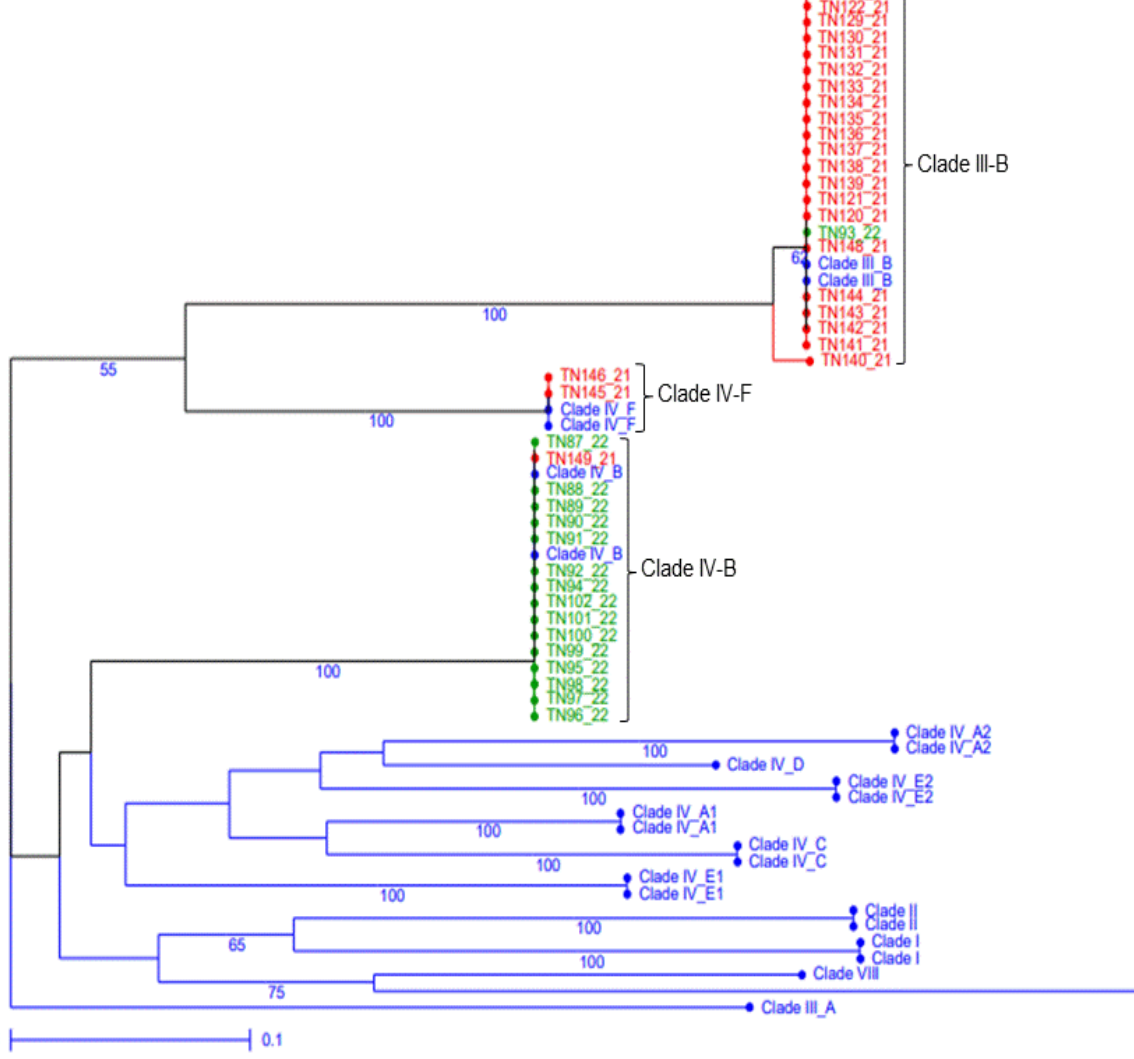
Figure 2. Consensus tree of 40 Pgt (3 isolates were not considered due to incomplete SSR data) iso- lates collected from Tunisia in 2021 and in 2022, presented in red and green colors, respectively, and 24 reference representative isolates of different Pgt clades [18], presented by their corresponding clade in blue color, based on genotyping data using 17 Pgt SSR markers [18]. Bootstrap values supporting the cluster at higher than 50% after 1000 iterations are shown above the internodes.